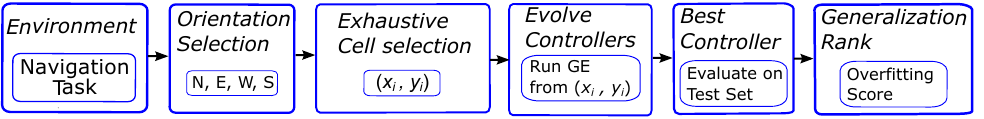
Figure 6. High level description of the proposed experimental work for both manually selected and exhaustive experiments. Table 1. Parameters used for the experimental work. Codons-min and Codons-max are the minimal and maximal number of codons in the initial random population of the GE